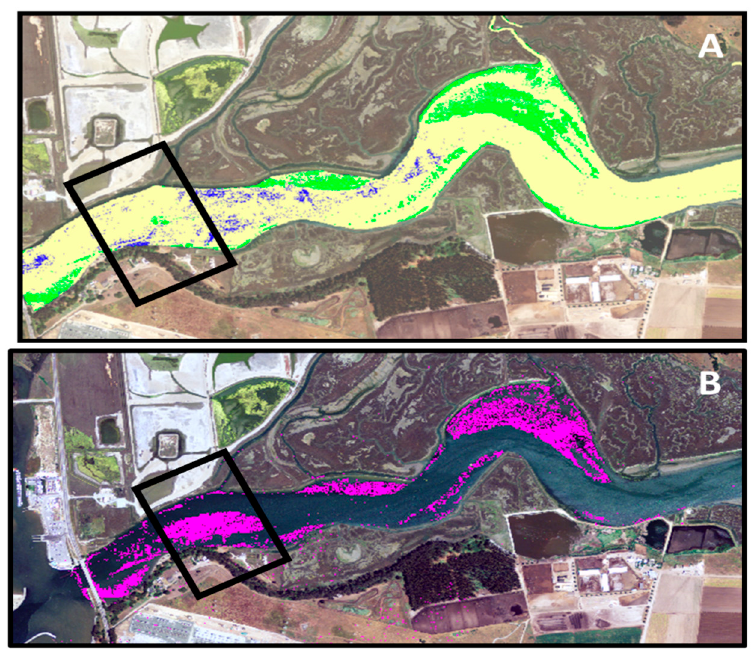
Figure 10. Habitat maps developed from the hyperspectral imagery using ( A ) a red edge threshold approach from Hill et al. (2017) and ( B ) the HOPE inversion model. The magenta pixels include those with benthic reflectance corresponding to eelgrass. The black box outlines the deeper Vierra bed which was only visible with the HOPE model.